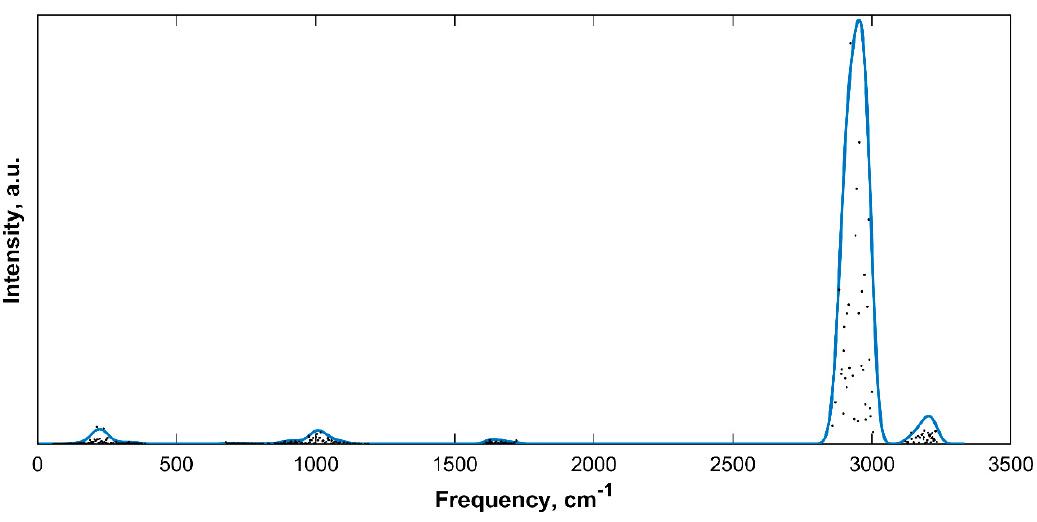
Figure 1. IR spectra of empty sH gas hydrate at equilibrium (0 K, 0 GPa). Gaussian convoluted spectra (line) and raw IR spectra (dots).